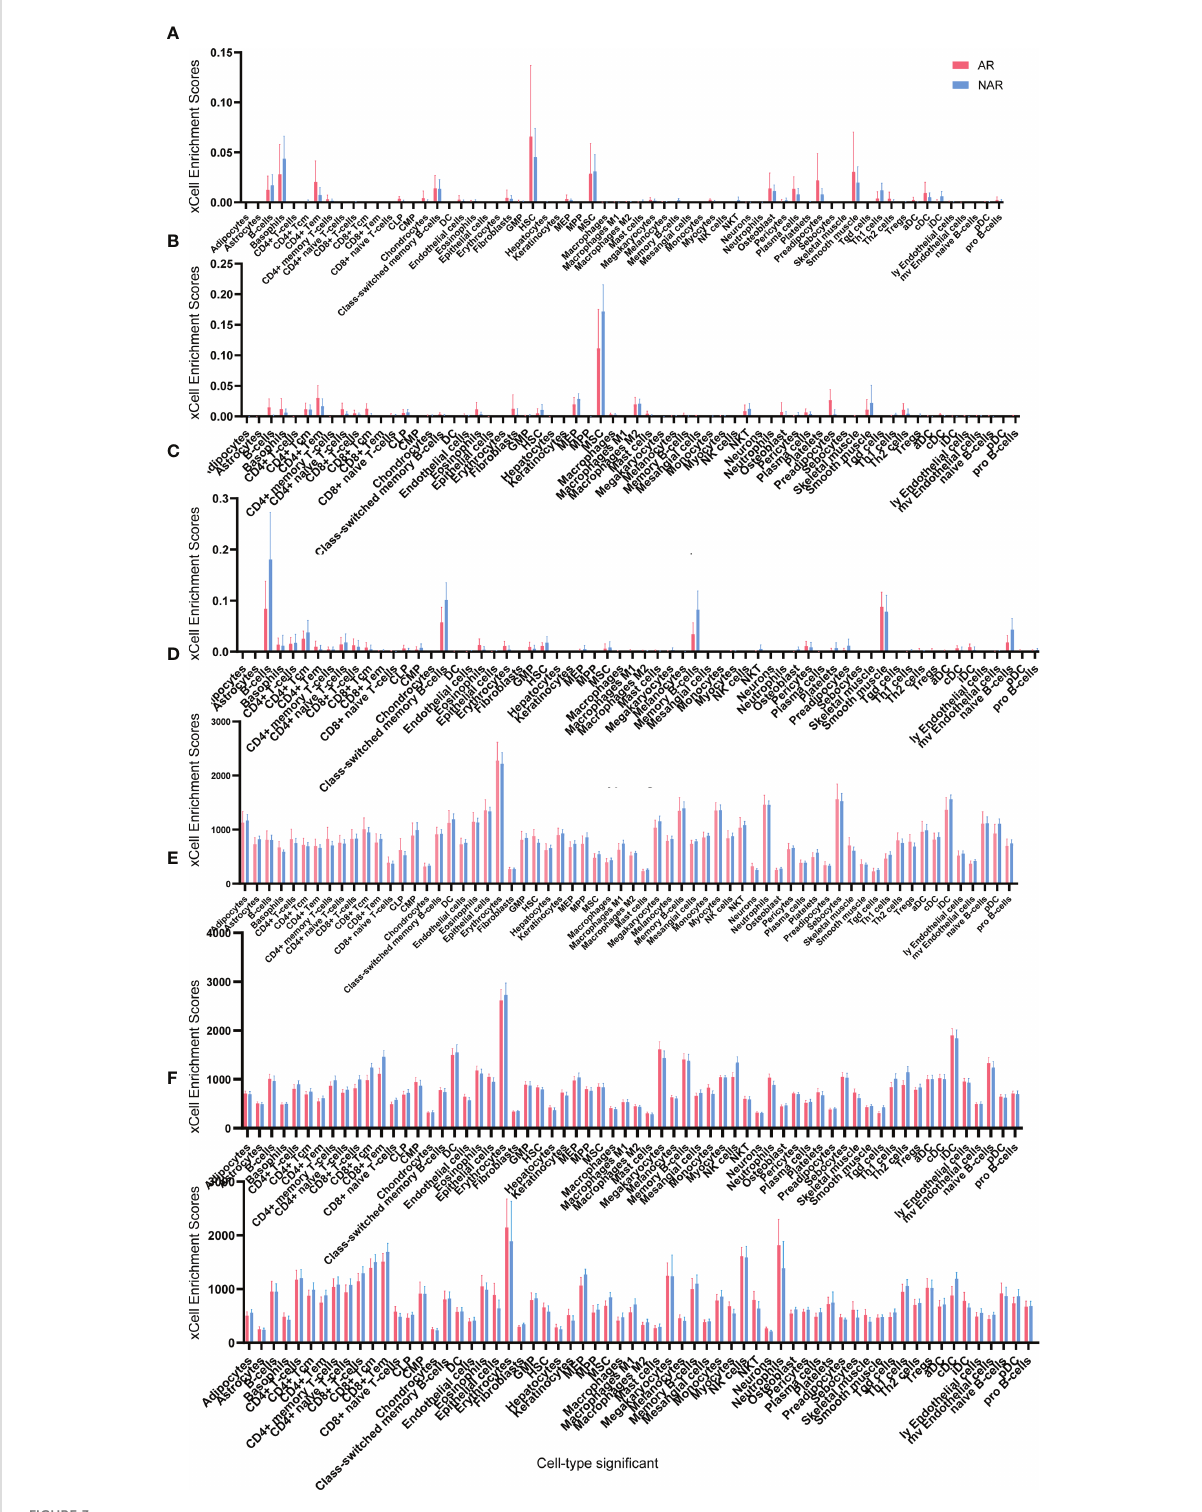
FIGURE 3 Cell type enrichment analysis of six RNA sequencing datasets. (A) GSE145503, (B) GSE131179, (C) GSE120649, (D) GSE120396, (E) GSE112927, and (F) our center) were performed using the xCell website. The x-axis lists the 64 cell types, and the y-axis depicts the xCell enrichment score (FDR < 0.1) in the AR group compared to the NAR